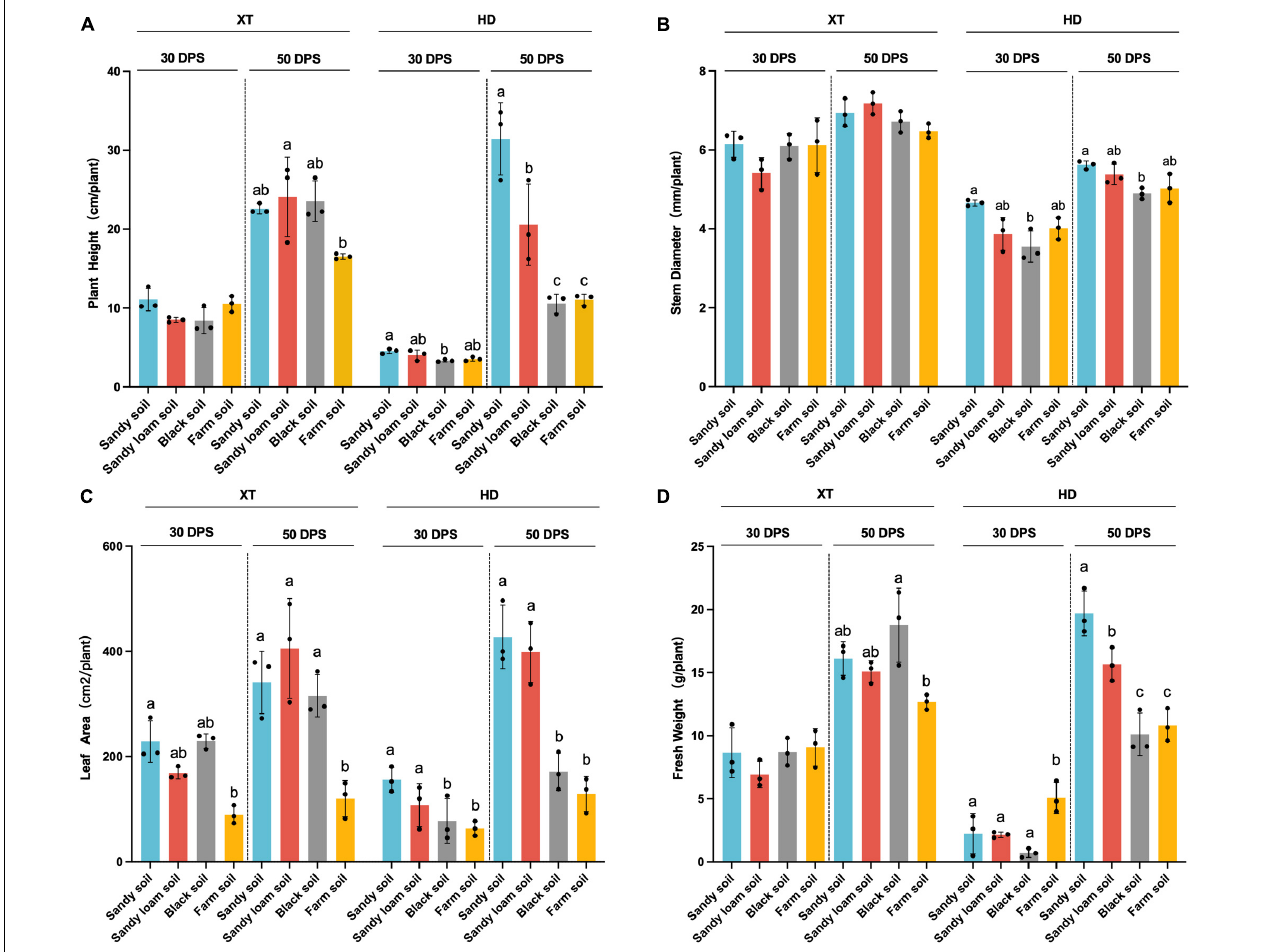
FIGURE 2 | Statistical analysis of physiological characteristics. (A) Plant height of XT and HD in four different soils. (B) Stem diameter of XT and HD in four different soils. (C) Leaf area of XT and HD in four different soils. (D) Fresh weight of XT and HD in four different soils. Statistics recorded data of 30 and 50 DPS. Significances are indicated among different groups by P -values (ANOVA, Turkey HSD). Data are the means of three replicates, and error bars indicate standard deviations. Different lowercase letters indicate a significant difference ( p < 0.05) in Tukey’s